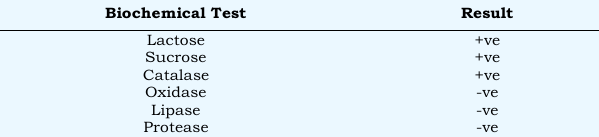
Table 4 Biochemical tests for detecting K. pneumoniae isolates under